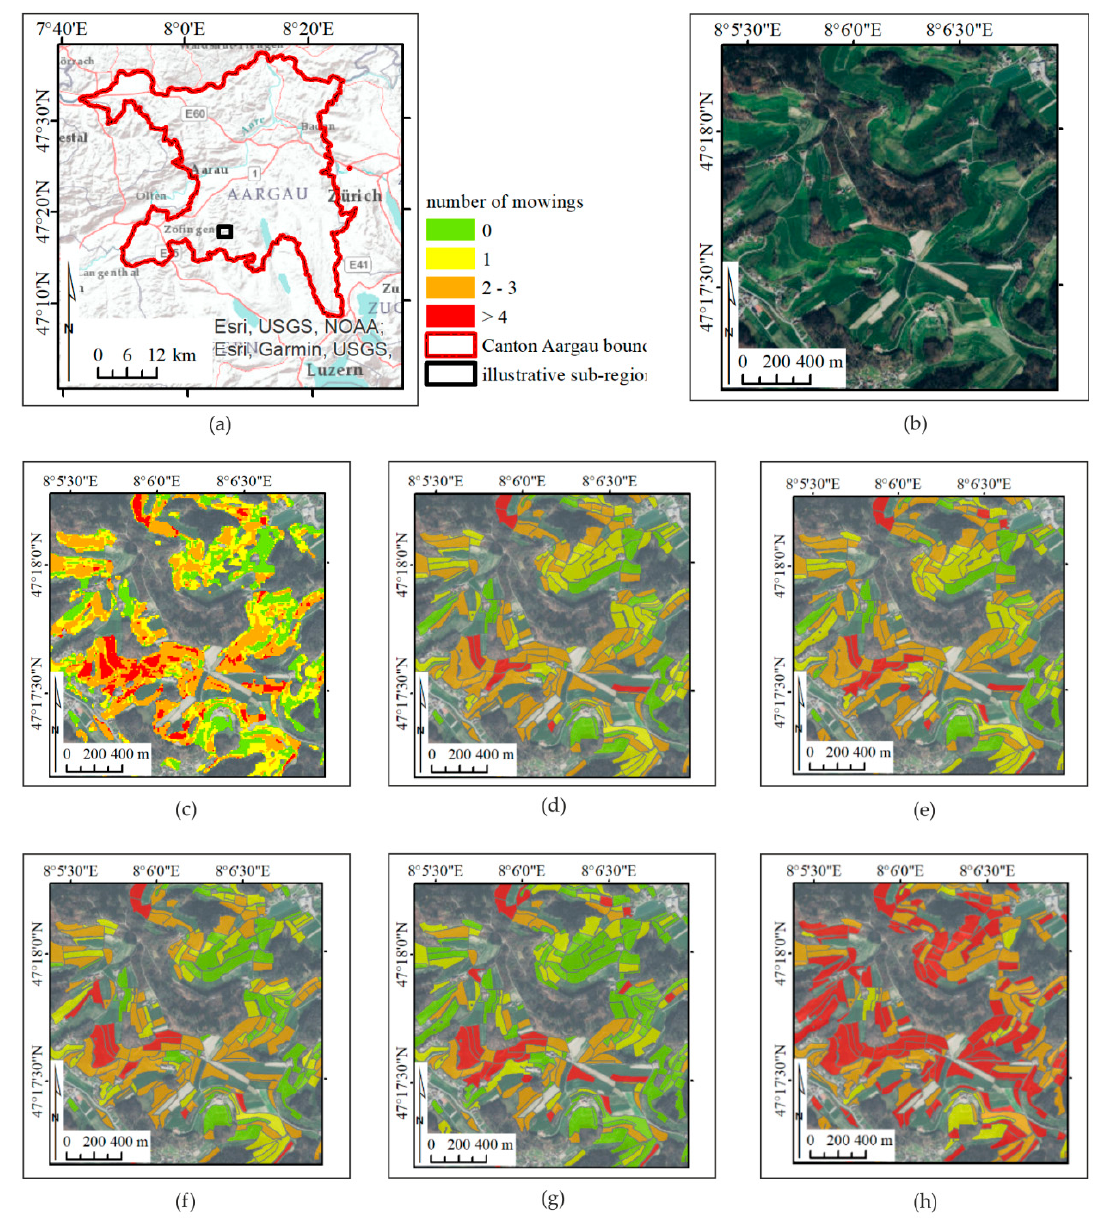
Figure 8. Representative sub-region in the South of Canton Aargau, based on various spatial mapping units, and standard and optimized time series: ( a ) illustrative sub-region location in Canton Aargau; ( b ) orthophoto map of the sub-region; ( c ) Experiment 1a, optimized-pixel; ( d ) Experiment 1b, optimized-pixel—aggregated to parcels; ( e ) Experiment 1c, optimized-pixel—aggregated to shrunken parcels; ( f ) Experiment 2, optimized-parcel; ( g ) Experiment 3, optimized-shrunken-parcel; and ( h ) Experiment 4, standard-shrunken-parcel.